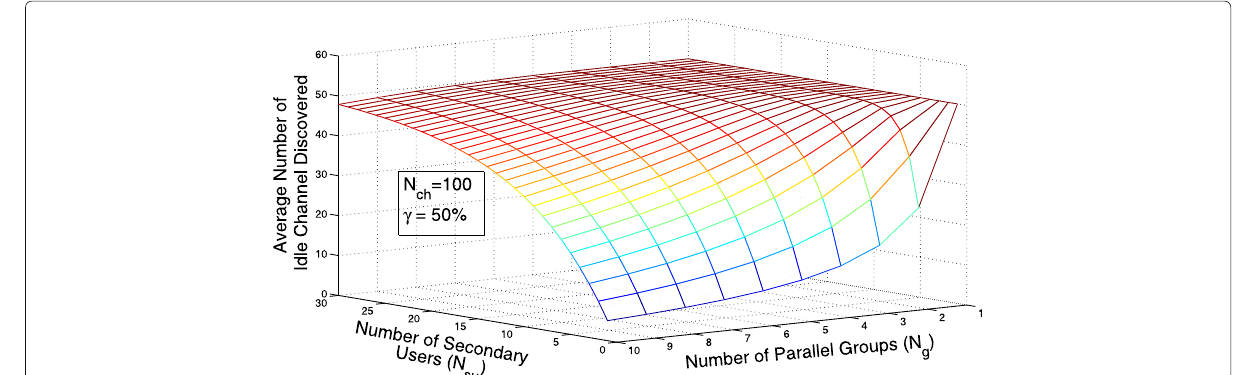
Fig. 5 Average number of idle channels discovered by SUs when primary load γ =